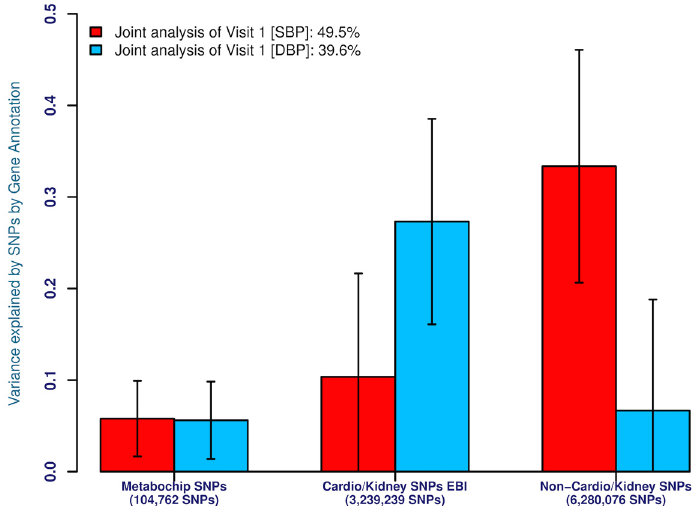
Cardio/Kidney SNPs EBI = Markers associated with cardiovascular traits annotated by EBI; Non-Cardio/ Kidney SNPs = Markers with no known association with cardiovascular or renal tissue) in 8,901 EA individuals. The trait analyzed is first-visit SBP and DBP with analyses for genotyped and imputed SNPs, (b) Legend as in (a) but for 2,860 AA individuals.